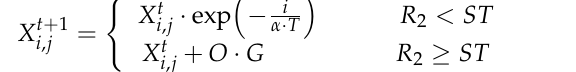
Figure 1. The Gantt chart of the instance mentioned in Table 1.